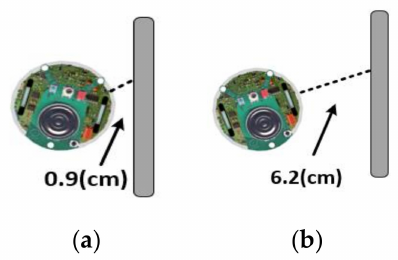
Figure 18. ( a ) Collision between the mobile robot and the wall; ( b ) the mobile robot deviated